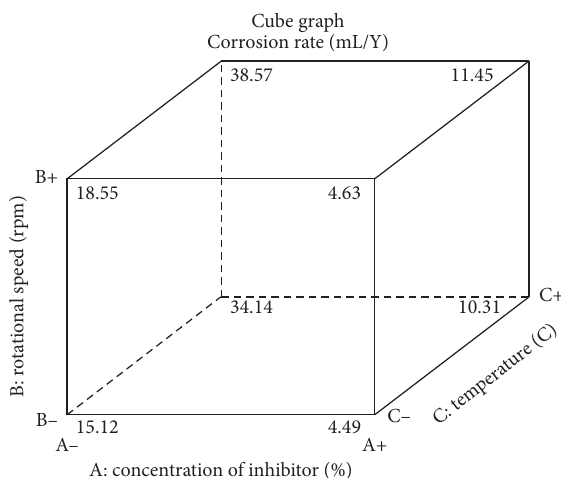
Figure 12: 3D plot of corrosion rate as a purpose of inhibitor load, rotation speed, and temperature variables.